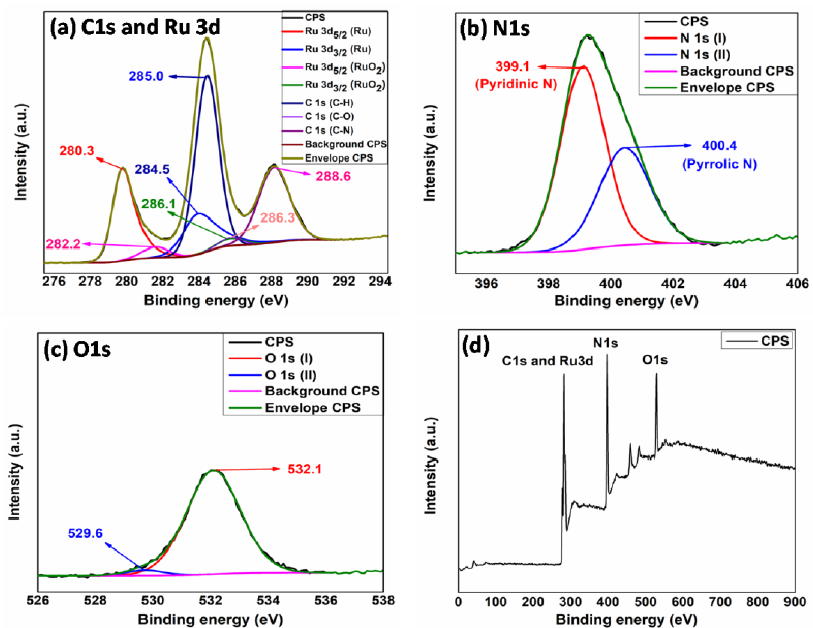
Figure 5. Deconvoluted X ‐ ray photoelectron spectroscopy (XPS) spectrum of C1s and Ru 3d ( a ), N1s ( b ), O1s ( c ) andsurvey spectrum of elements ( d ) in Ru ‐ GCN material.